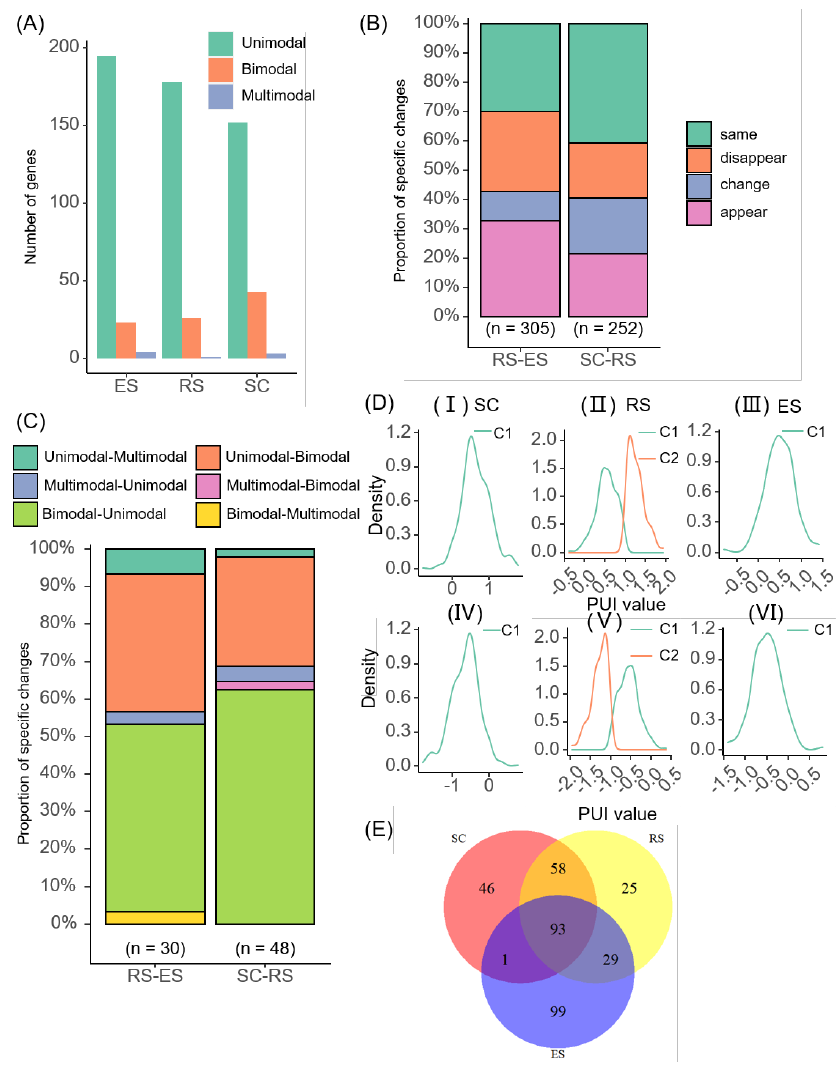
Figure 5. Non- 3′ UTR APA modality. ( A ) Statistics on the number of poly(A) sites with detectable usage patterns in different cell types of non- 3′ UTR; ( B ) statistics on changes in poly(A) sites with detectable usage patterns of non- 3′ UTR cells in the two differentiation stages; ( C ) statistics on changes in poly(A) sites usage patterns of non- 3′ UTR in the two differentiation stages; ( D ) the density distribution of proximal (I – III) and the distal (IV – VI) poly(A) site of Crem in different cell types; ( E ) statistics on the number of poly(A) sites with detectable usage patterns corresponding to genes with non- 3′ UTR APA in different cell types.